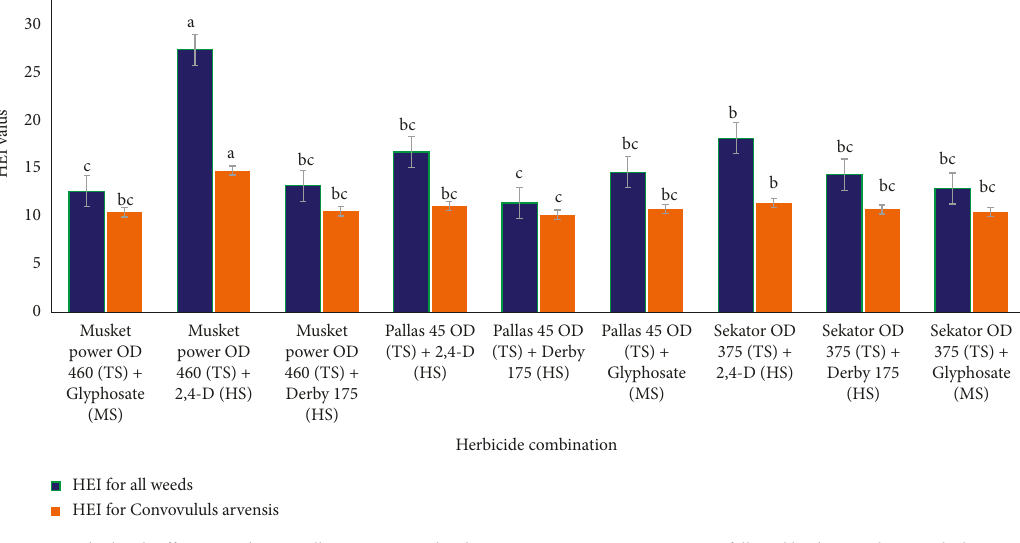
Figure 3: Effect of different weed control treatments on herbicide efficiency index in tef (combined mean of 2020 and 2021 year). HEI, herbicide efficiency index; TS, tillering stage; HS, heading stage; and MS, maturity stage. Means followed by the same letter in the bar graphs are not significantly different according to Fisher’s protected LSD at P < 0 .